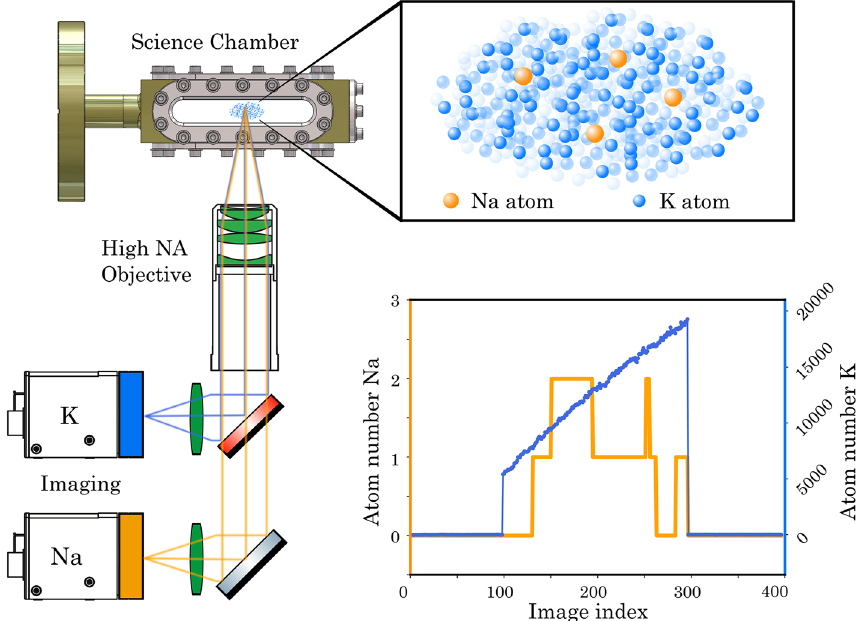
Figure 1. Experimental platform for atom counting. The atoms are trapped and laser cooled in a dual-species MOT inside the science chamber. The emitted fluorescence is collected by a high-resolution imaging system onto the cameras. We observe the stochastic dynamics of single sodium atoms (orange) surrounded by a large cloud of potassium atoms